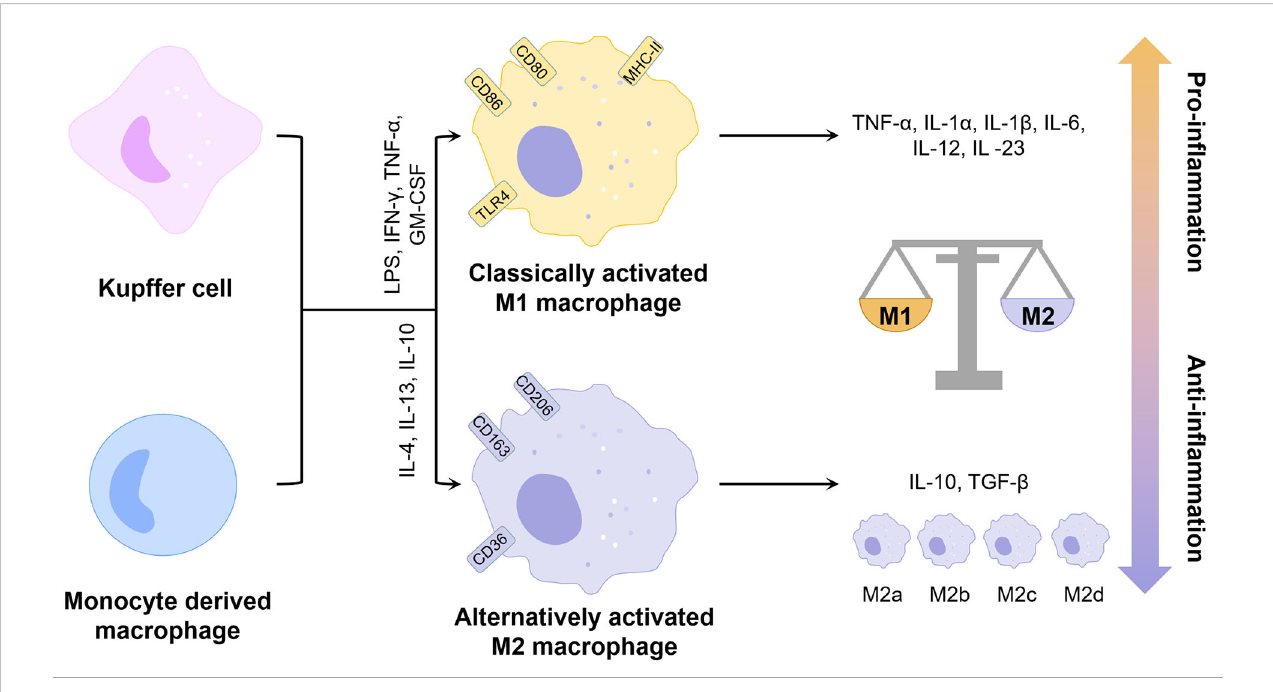
FIGURE 1 Phenotype and function of liver macrophages. KCs and monocyte-derived macrophages can be polarized by different factors into two distinct phenotypes, classically activated M1 and alternatively activated M2. M2 macrophages can be further classi fi ed into multiple phenotypes. Overall, M1 exhibits pro-in fl ammatory properties and M2 exhibits anti-in fl ammatory properties. The balance between the two determines the direction of liver in fl ammation. GM-CSF, granulocyte-macrophage colony-stimulating factor; IFN- g , interferon- g ; IL, interleukin; LPS, lipopolysaccharide; MHC-II, major histocompatibility complex class IITGF- b , transforming growth factor- b ; TLR4, toll-like receptor 4; TNF- a , tumor necrosis factor- a